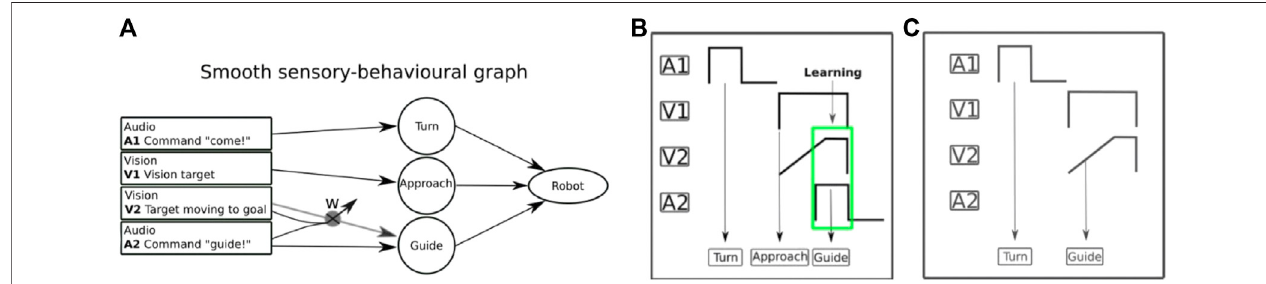
FIGURE 10 | Learning transitions between behaviors in use case 2: (A) sensory-behavioral graph in the transition of guiding when the user approaches the robot. A1,V1,V2,andA2aresensoryinputsoftheSMOOTH-robot.A1isanaudioinput(i.e.,humancommand “ comehere! ” ).V1isavisualinput(i.e.,humanfacerecognition). V2isanothervisualinput(i.e.,humanmotiondetection).A2isanotheraudioinput(e.g.,thehumancommand “ guideme! ” ). W referstoanadaptiveconnectionthatwillbe established after learning. It will transmit a predictive signal (i.e., human approaching detection) to activate the guiding behavior. (B) In the fi rst iteration, the robot perceived the fi rst audio input and turned toward the user call or sound source (A1 → Turn). After that, the robot visually detected the user and then approached (V1 → Approach).Thentherobotdetected thehumanmotion(i.e.,V2,humanwalkingtowardtherobotasapredictivesignal)andthereafterhumanspeech(i.e.,A2,guideme! as a re fl ex signal) which fi nally leads to robot guiding behavior (A2 → Guide). In this process, the robot also learned that the inputs V2 (predictive signal) and A2 (re fl ex signal) are correlated (learning process), meaning that the human motion implied a need for the guiding behavior. (C) After learning, the robot fi rst perceived the sound and turnedtoward thesound source (A1 → Turn). Afterward, itdetectedthehuman(V1) and his motion(V2). Itthen immediately performed theguidingbehaviorwithout its approaching behavior. In this process, the robot basically proactively skipped its approaching behavior. In other words, the robot will perform guiding behavior as soon as it detects the movement of the human toward a given target location (e.g., the dining room).